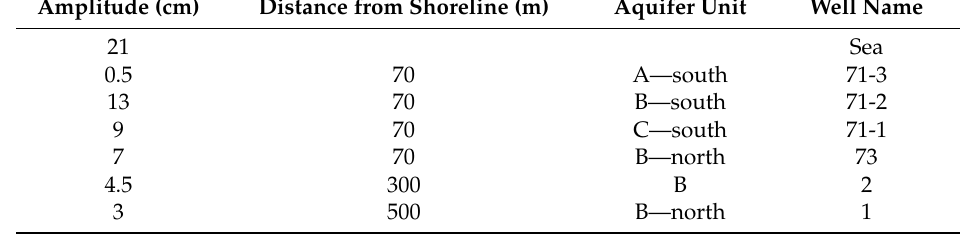
Table 1. Maximum tidal amplitudes in different units and distance from shoreline during May 2014. Amplitude (cm) Distance from Shoreline (m) Aquifer Unit Well Name